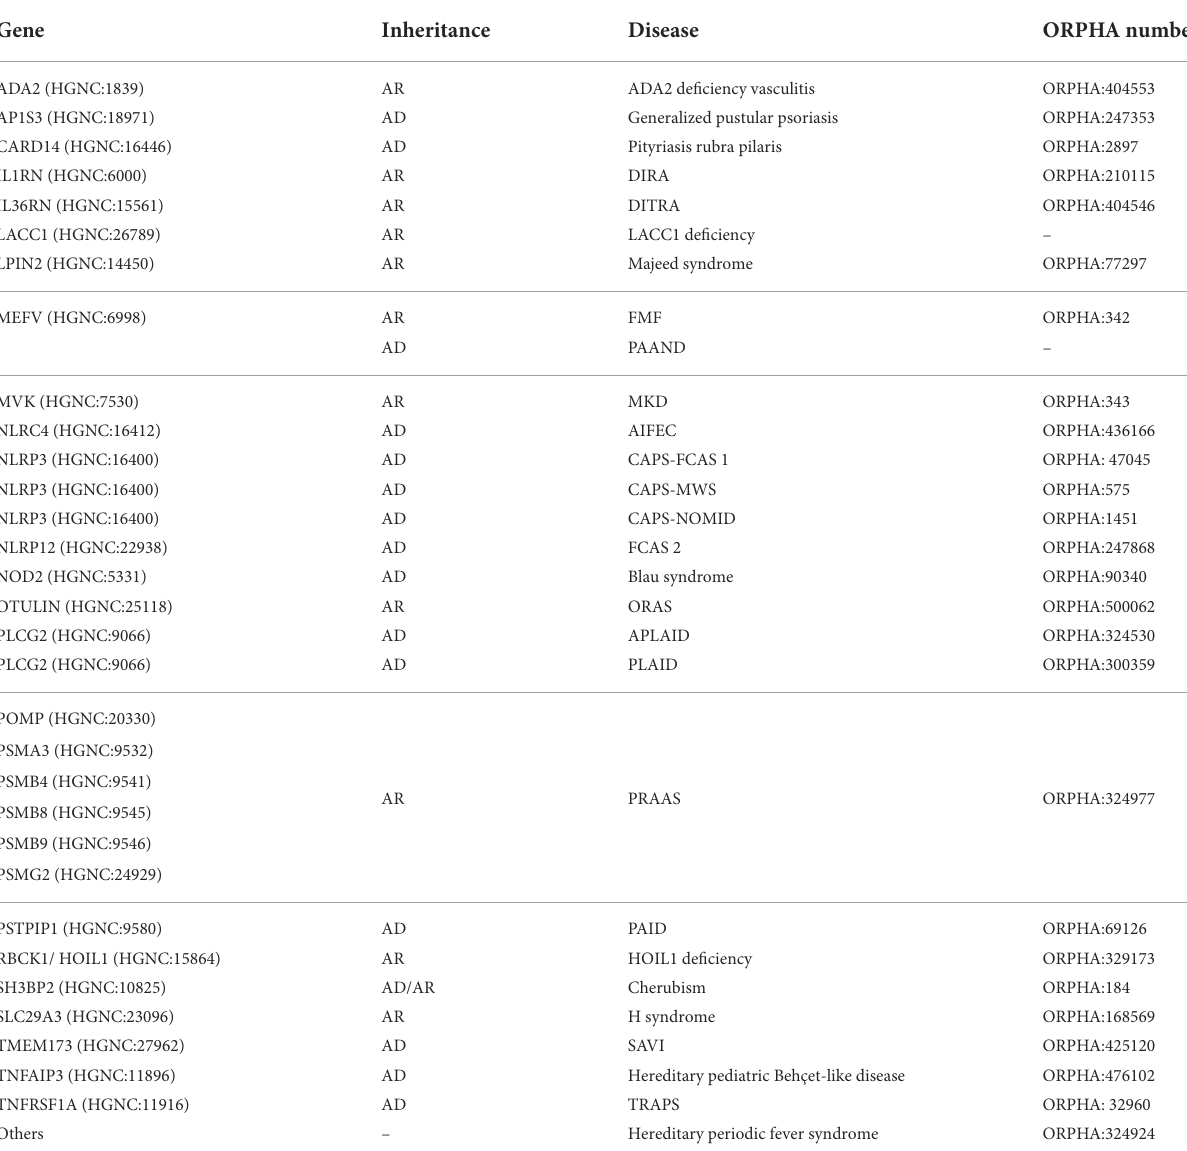
TABLE 1 List of genes/diseases covered by the Autoinflammatory Diseases Alliance Registry of monogenic autoinflammatory diseases. Gene Inheritance Disease ORPHA